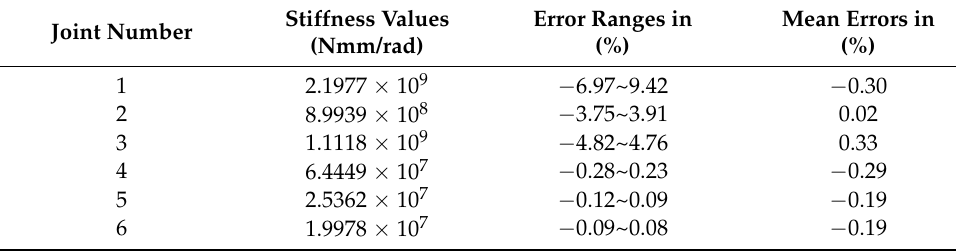
Table 5. The values and errors of joint sti ff ness.